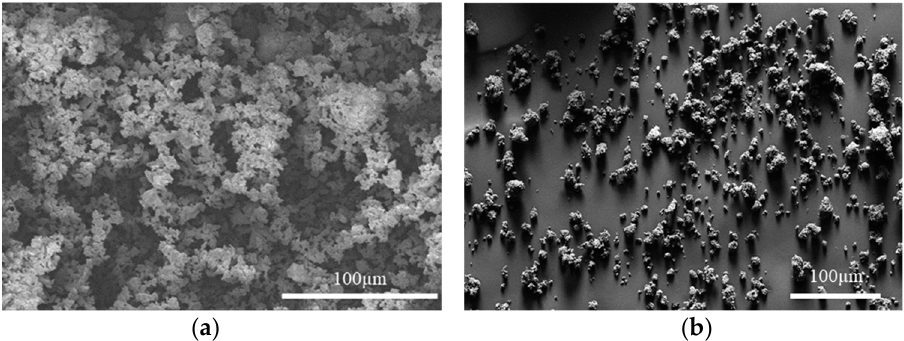
Figure 4. SEM secondary electron images showing ( a ) as-received CeN powder particles in large agglomerates and ( b ) milled CeN powder particles in small